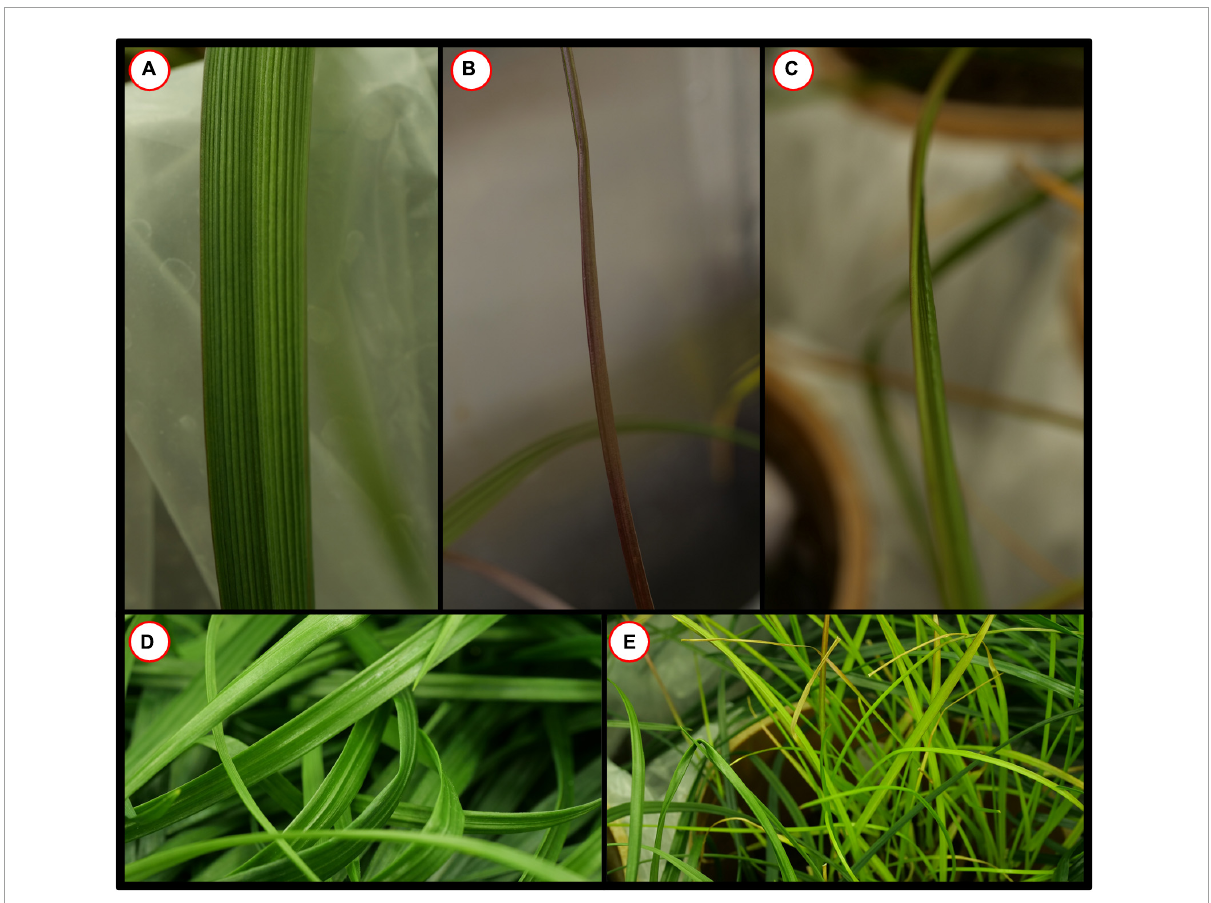
FIGURE2 Perennial Ryegrass ( Lolium perenne ) leaf morphology example images for selected harvests and water status. (A) DAS 72 non-waterlogged. (B) DAS 72 waterlogged. (C) DAS 72 waterlogged. (D) DAS 101 non-waterlogged. (E) DAS 101 waterlogged. Examples images are not color